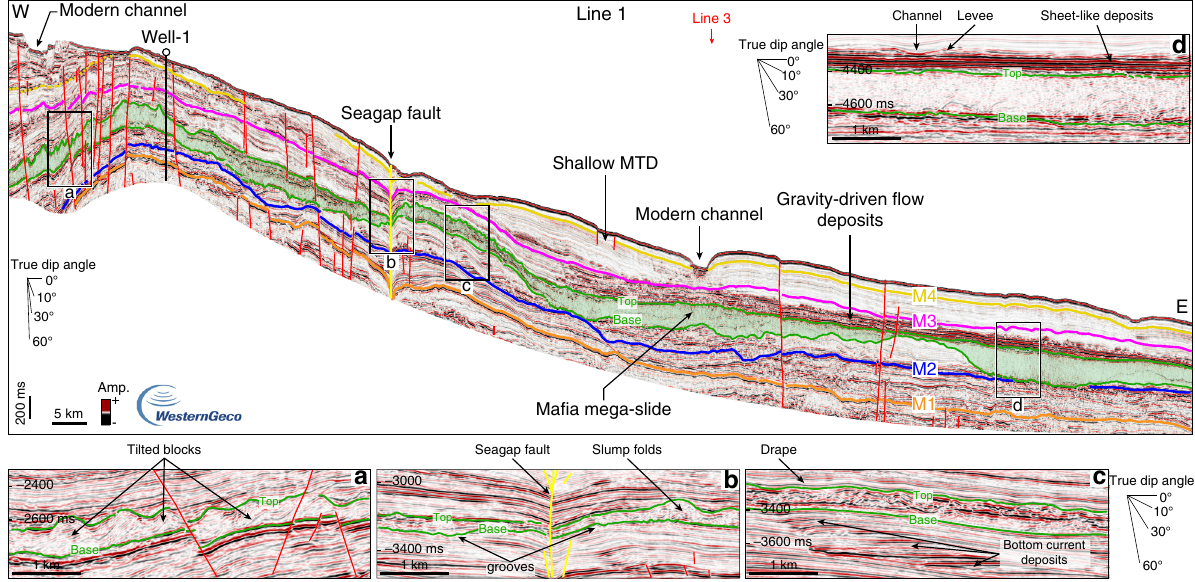
Fig. 3 Stratigraphy of the Tanzania margin imaged by a downslope-oriented seismic line crossing Well-1. Seismic Line 1, oriented W-E and intersecting seismic Line 3 (red arrow), is perpendicular to the slope of the western Indian Ocean offshore the Ru fi ji River delta (location in Fig. 1). Insets a – d highlight the morphological and seismic expression variability of the Ma fi a mega-slide and bounding units. M1 – M4 are the main seismic horizons identi fi ed in this study and tied to the two wells (see Fig. 2 for the ages). The Ma fi a mega-slide is highlighted in green. MTD: mass-transport deposit. Noninterpreted version of Line 1 is available in the Supplementary Fig.